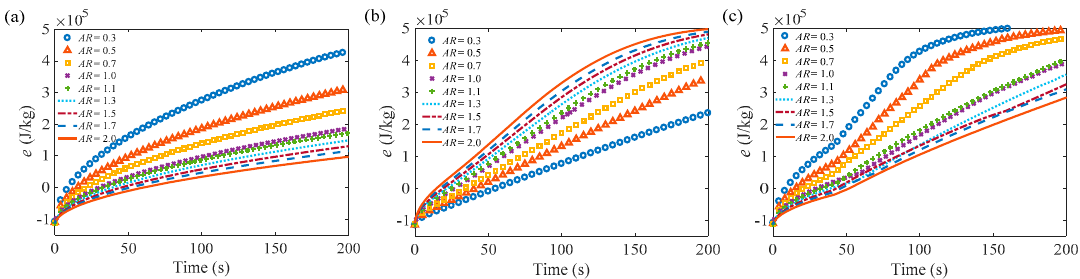
Figure 12. Enthalpy of the PCM in rectangular enclosures with different aspect ratios by heating the different sides. ( a ) Heating the top side; ( b ) heating the right side; ( c ) heating the bottom side.